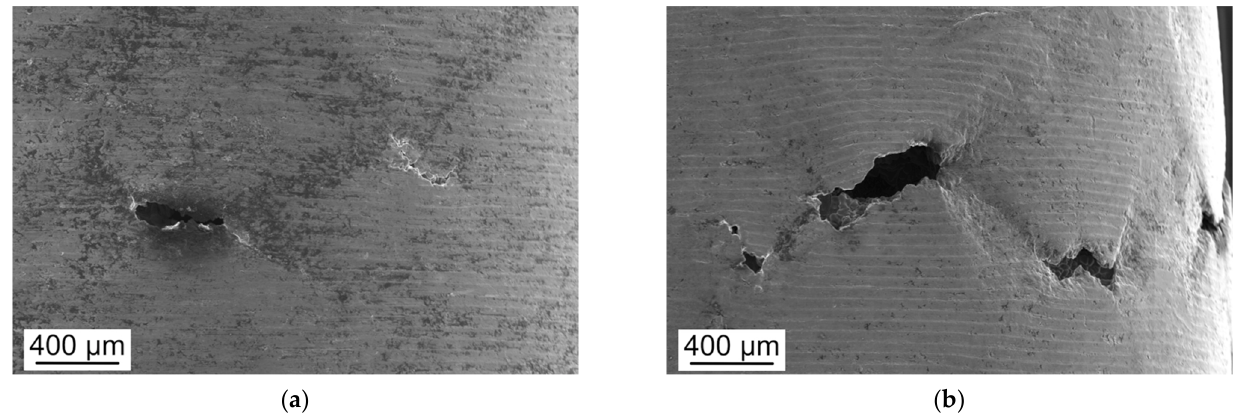
Figure 3. Lateral surface of crept specimen in alloy A356 ( a ) and EZ35 ( b ).